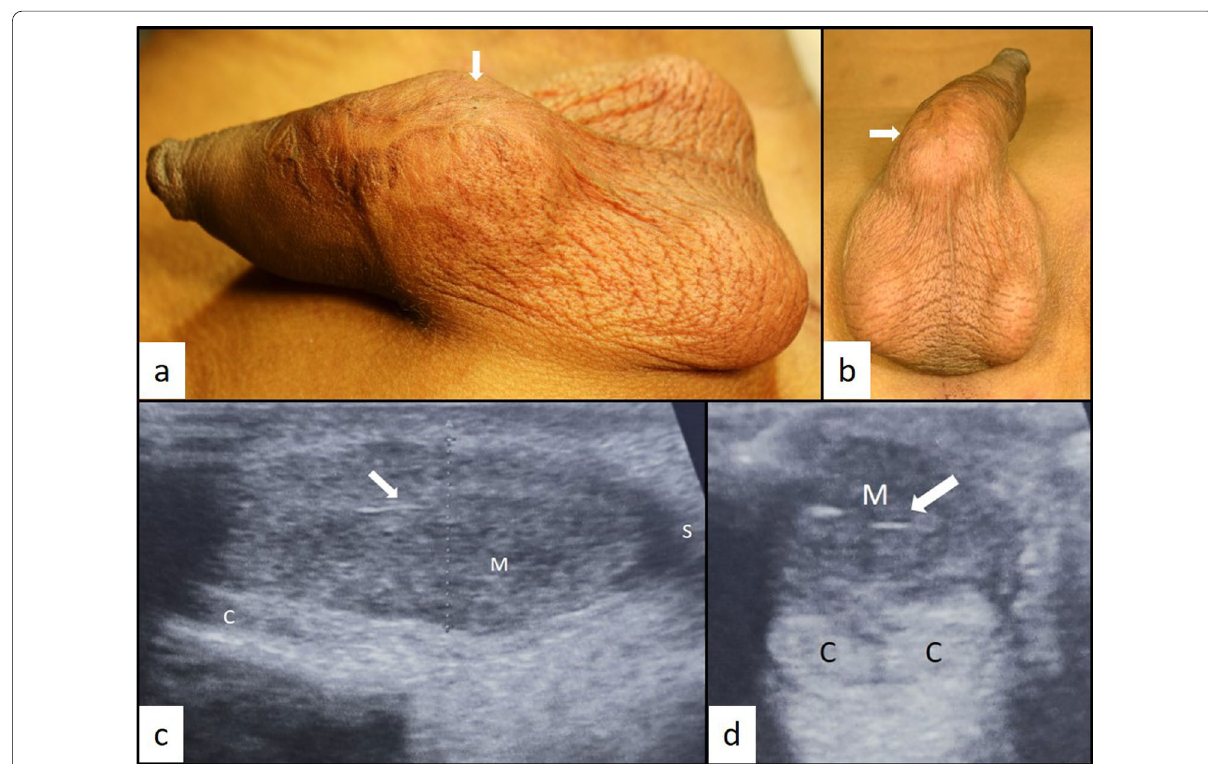
Fig. 1 Clinical photographs ( a , b ) showing a ventral, oblong, proximal penile bulge (arrow). Longitudinal ( c ) and transverse ( d ) sonographic gray scale images with the probe ventral, shows a well-circumscribed mass (M) in the corpus spongiosum (S), which is isoechoic to the corpus cavernosum (C). The mass (M) is encasing the proximal penile urethra